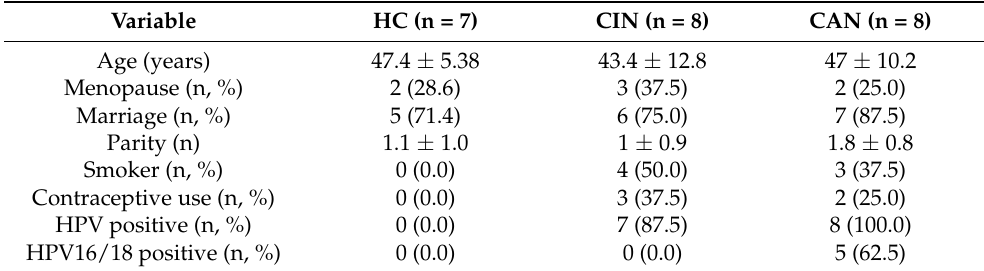
Table 1. Characteristics of the study subjects.